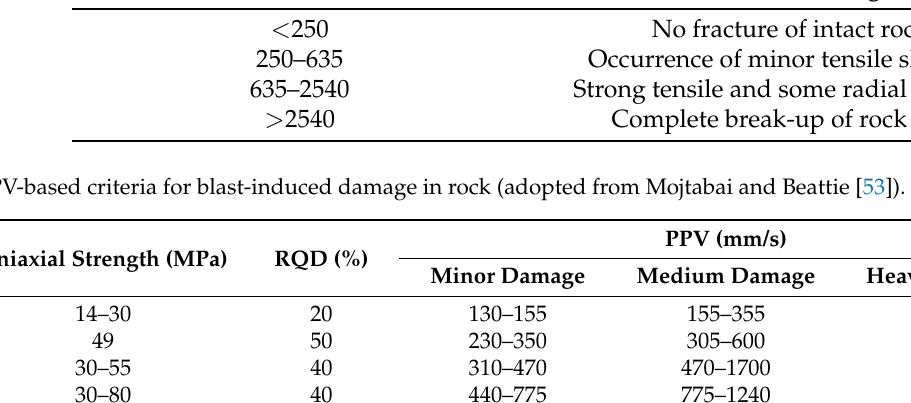
Table 2. PPV-based criteria for blast-induced damage in rock (adopted from Bauer and Calder [52]).